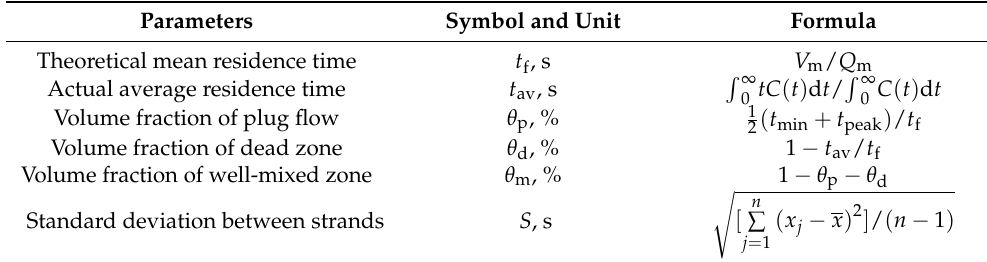
Table 3. Calculation formula of flow characteristic parameters of molten steel in tundish. Parameters Symbol and Unit Formula Theoretical mean residence time t f , s V m / Q m Actual average residence time Volume fraction of dead zone Volume fraction of well-mixed zone Standard deviation between